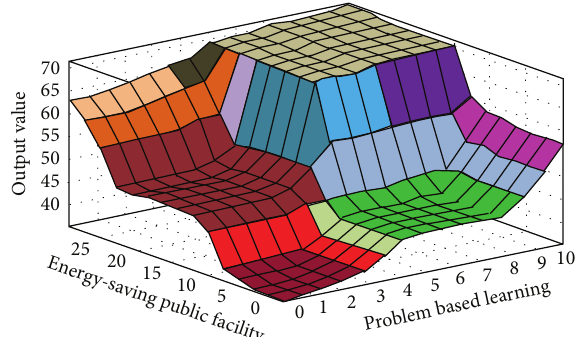
Figure 7: Input and output 3D mapping (energy-saving public facility and problem based learning).